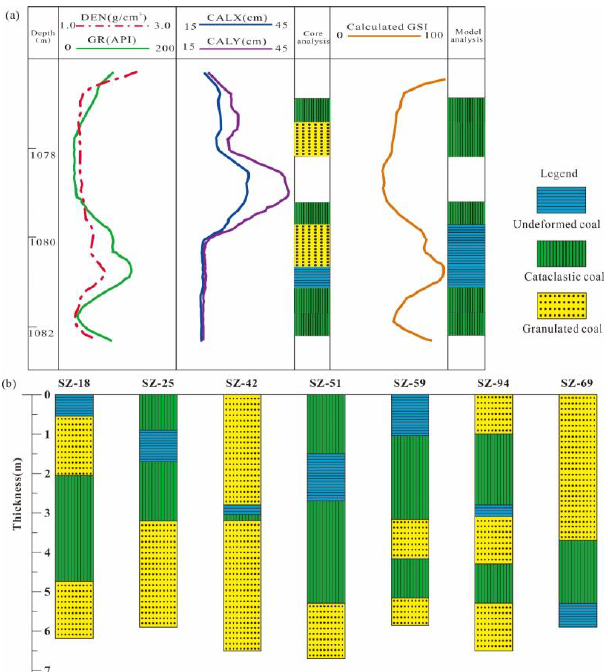
Figure 5. ( a ) Well SZ-001 Coring and GSI values for the coal seam section of typical CBM wells. ( b ) Vertical distribution of coal textures in a cross-sections in the Shizhuangnan Block. The results were inferred from the GSI model.